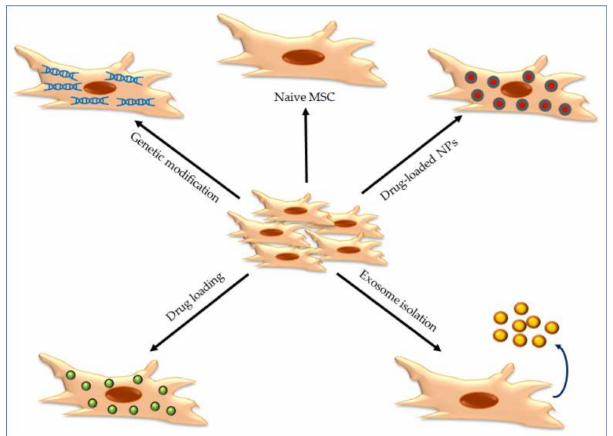
Figure 2. Mesenchymal stem cell (MSC)-based strategies for targeted-cancer therapy. MSCs can be used an anti-cancer agents due to their tumor-tropic properties, and their anti-proliferative, pro-apoptotic or anti-angiogenic properties (naïve MSCs). MSCs can be genetically modified to express suicide or anti-tumor genes. MSCs can incorporate small molecules of anti-tumor agents and they have been used as cellular vehicles of NPs. In addition, MSC-derived exosomes can be used as drug-delivery